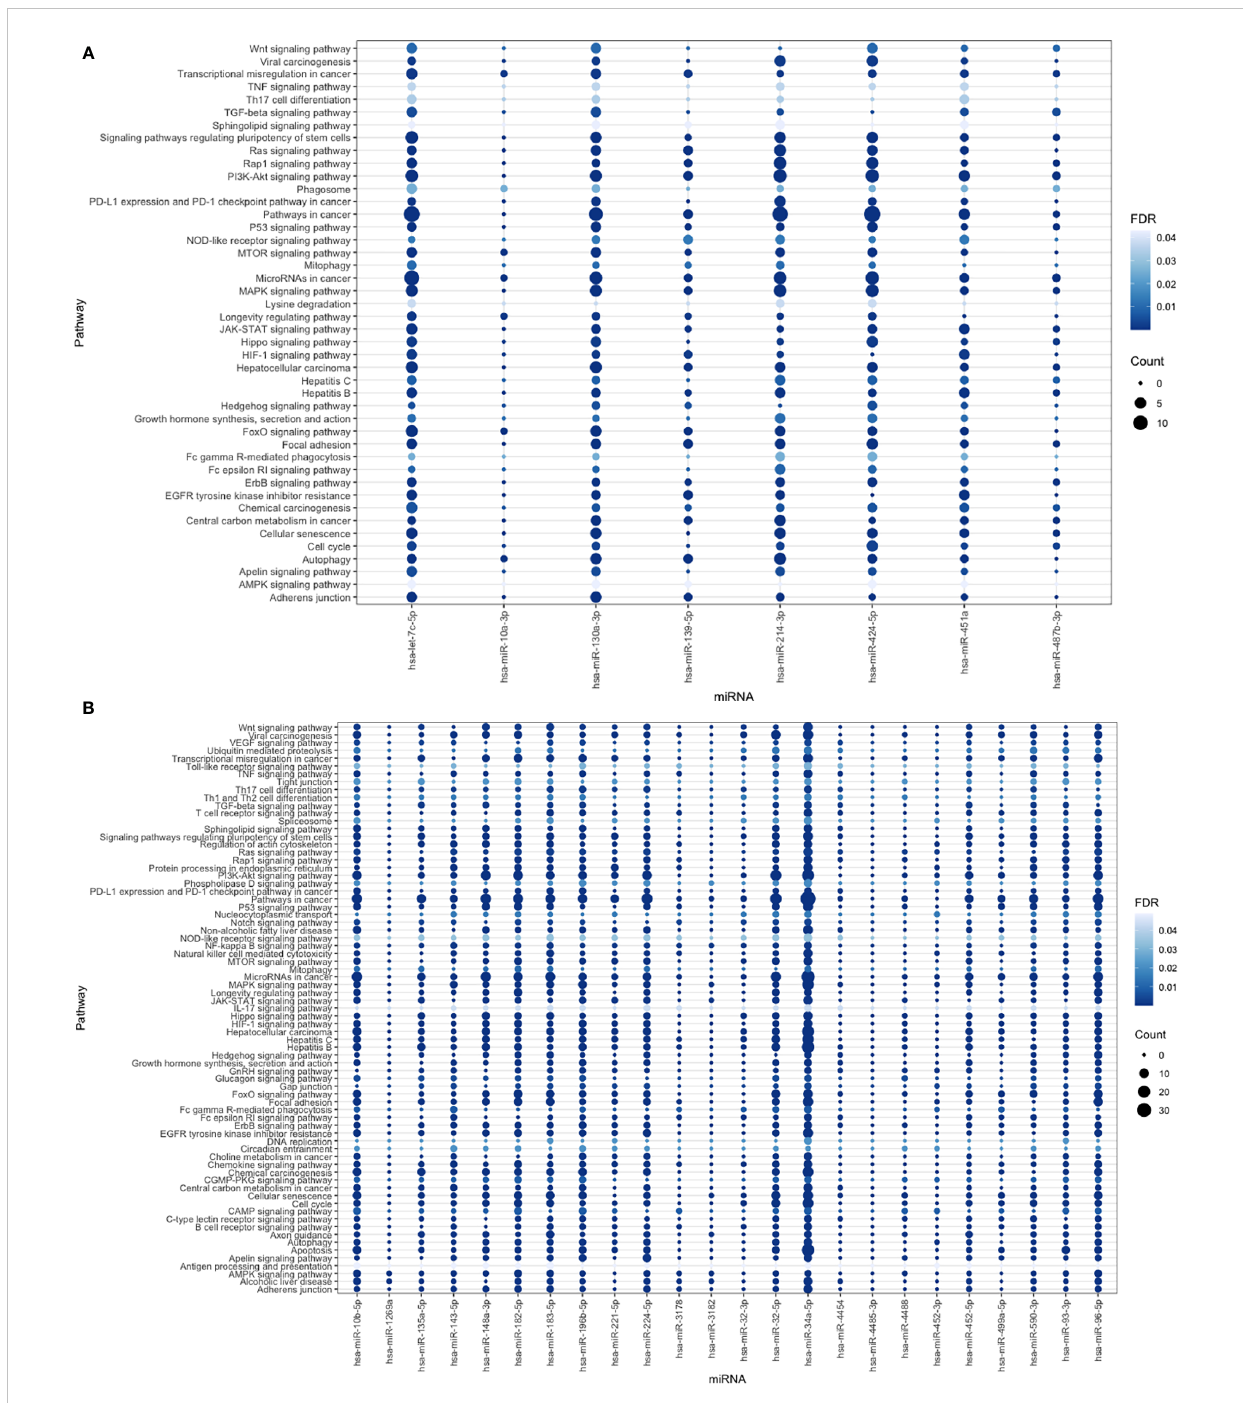
FIGURE 6 (A) The bubble plot represents miRNA-down regulated pathways with false discovery rate (FDR <0.05) indicated by degree of blue color and for number of interacted genes was represented by circle size. (B) Bubble plot for miRNA-up regulated pathways with number of interacted genes represented by circle size with FDR <0.05 represented by blue color